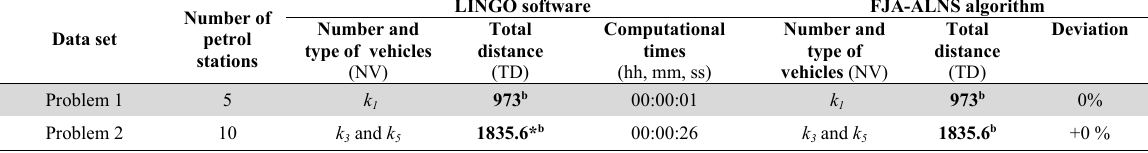
b Best known solution Comparison of solutions using LINGO software and the proposed FJA-ALNS